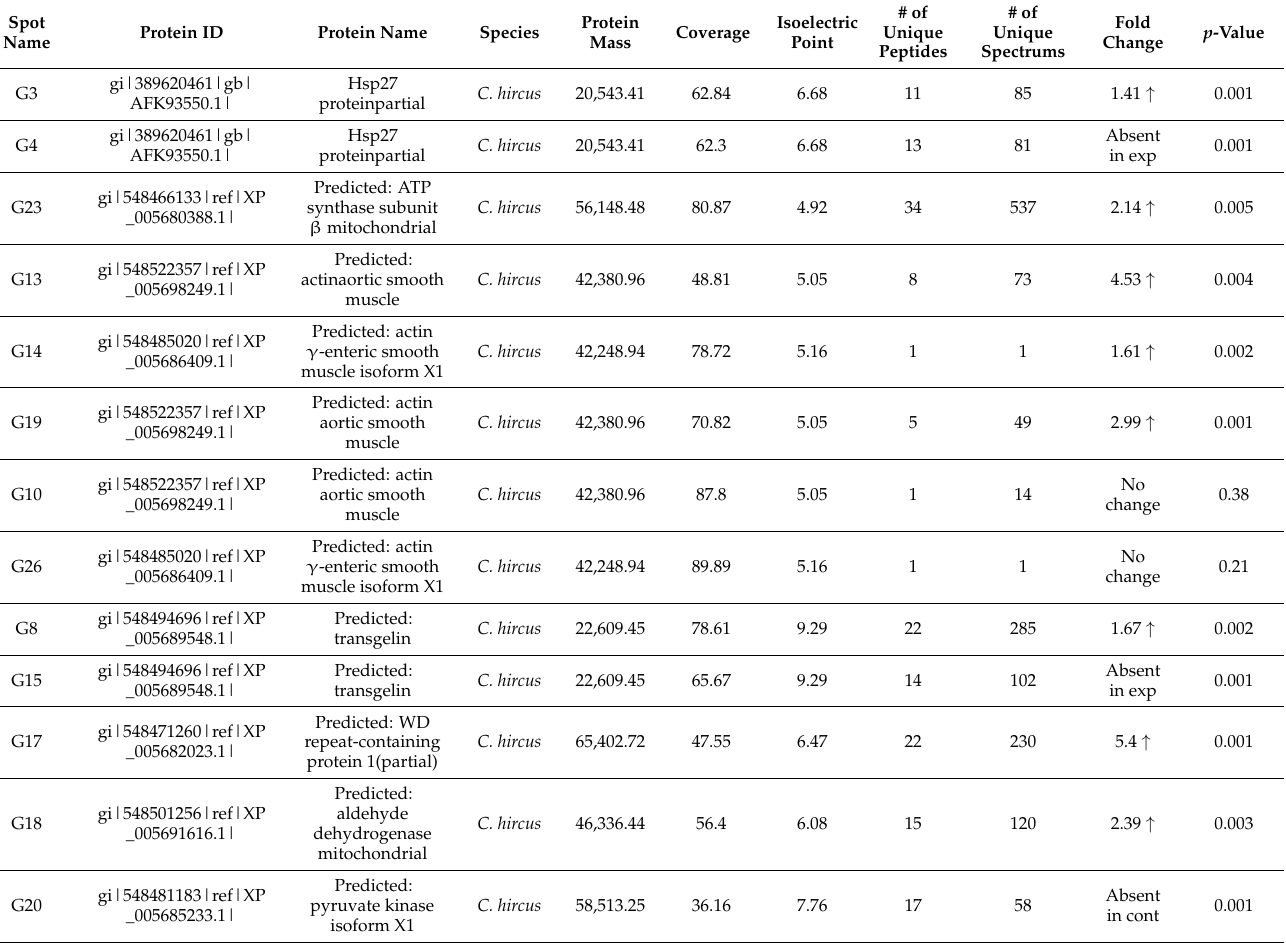
Table 3. Protein spots identified by LC-MS/MS in mesenteric artery proteomes. ↑ indicates upregula- tion of the protein spot. Fold change value was calculated by using the 2D gel image analysis software PD Quest (Bio-Rad) version 7.20. A value of p < 0.05 was considered to be statistically significant.